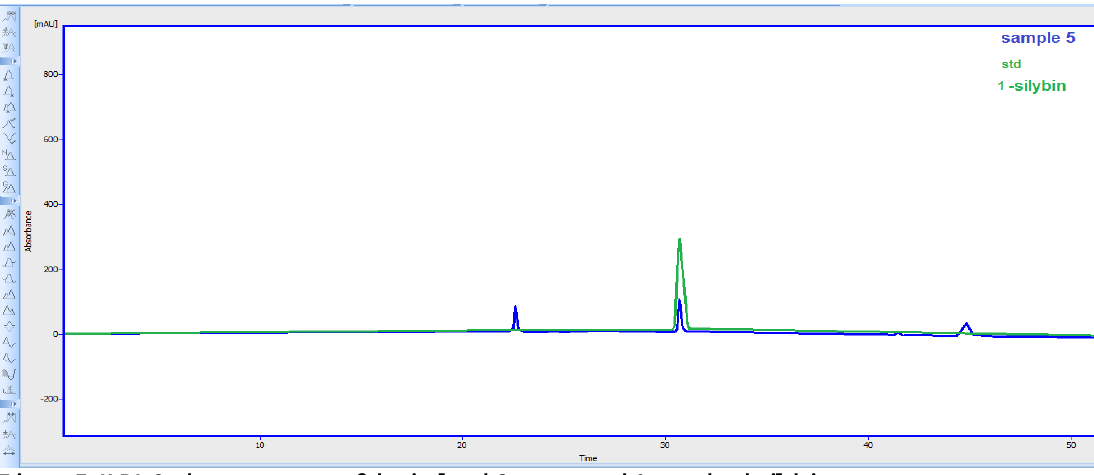
Figure 7. HPLC chromatogram of the isolated S compound &standard silybin TLC for the isolated